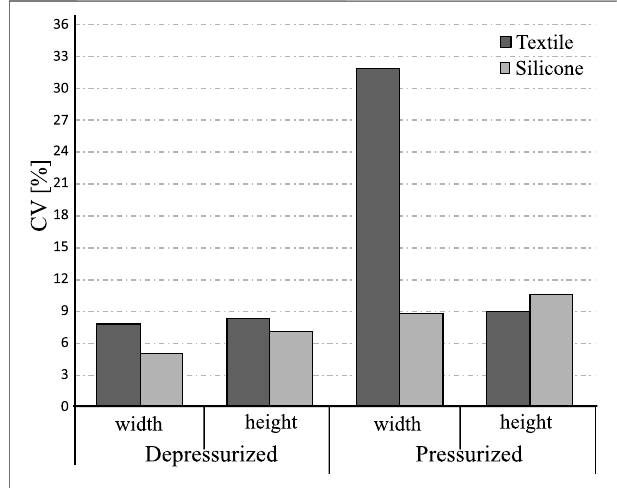
FIGURE 7 | The coef fi cient of variation calculated based on the three sections of the actuator (top, middle and bottom). The higher CV value means less accurate is the manufacturing method of the